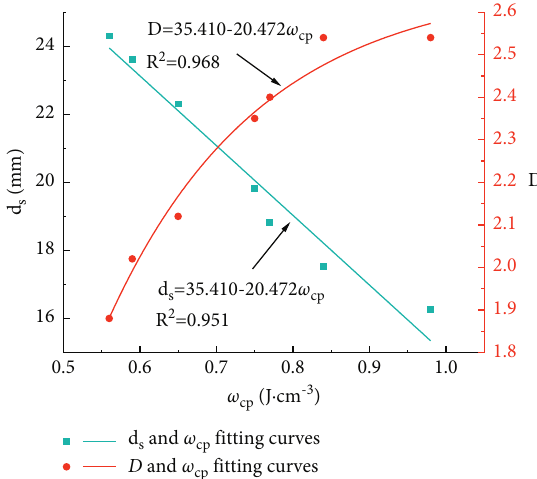
Figure 11: Relationship between average fragment size and specific energy absorption